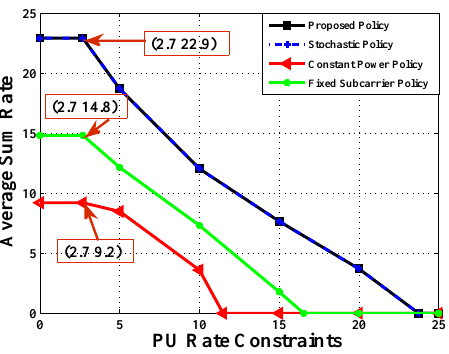
Figure 2: Average sum rate (Nats/s) versus the PU rate constraints (Nats/s). α = 1 , P s = 10 Watt.